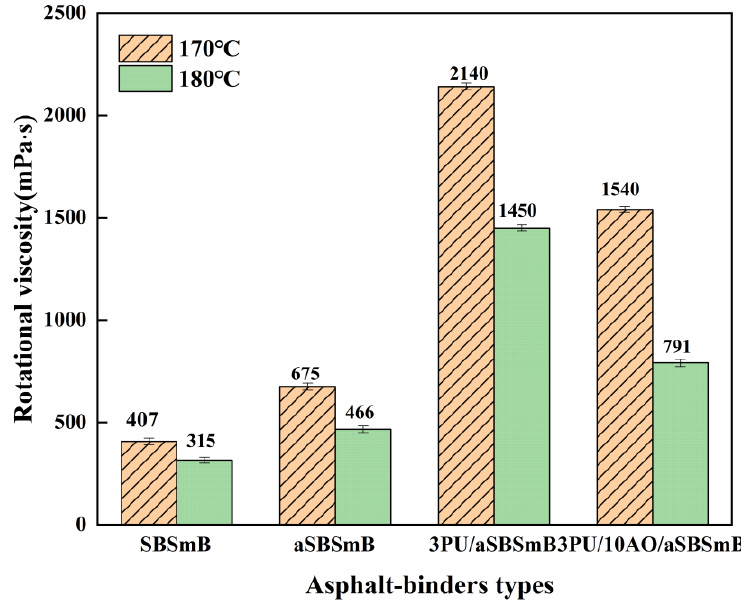
Figure 3. Effect of reaction rejuvenation on the viscosity of aSBSmB.